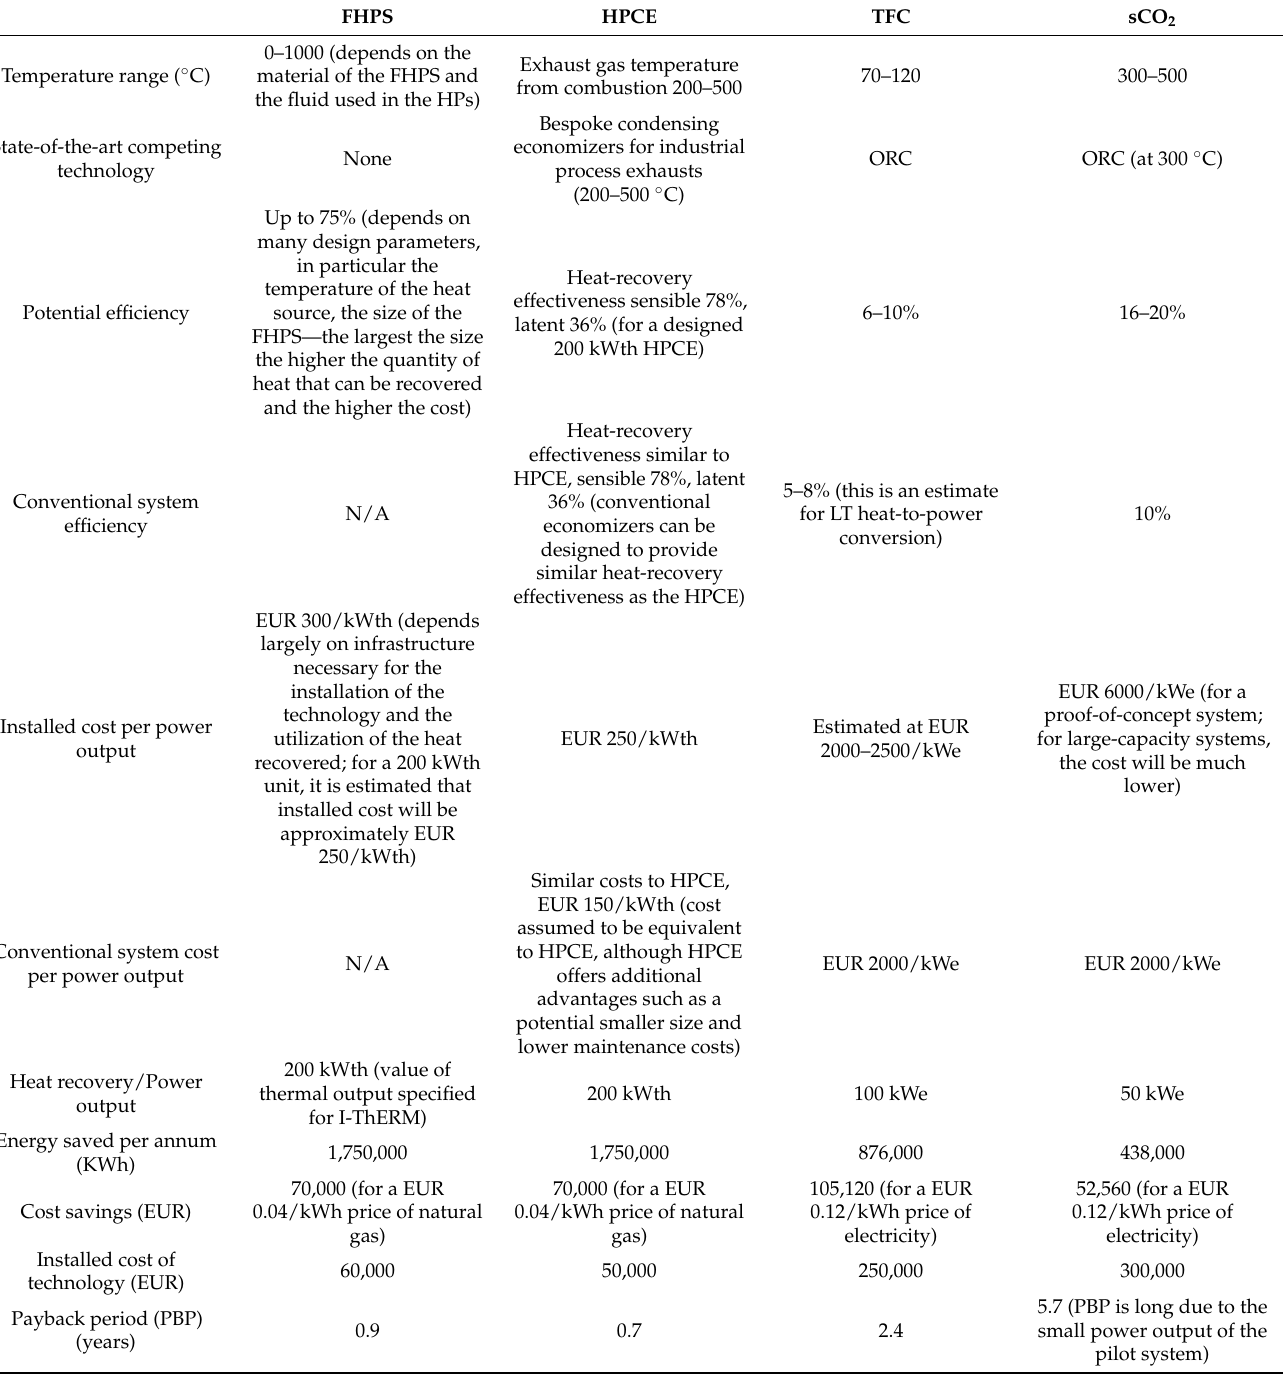
Table 1. Expected performance of “new” WHR technologies